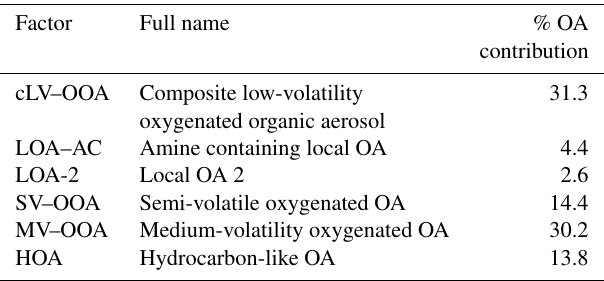
Table 1. AMS six components of PMF analysis by Docherty